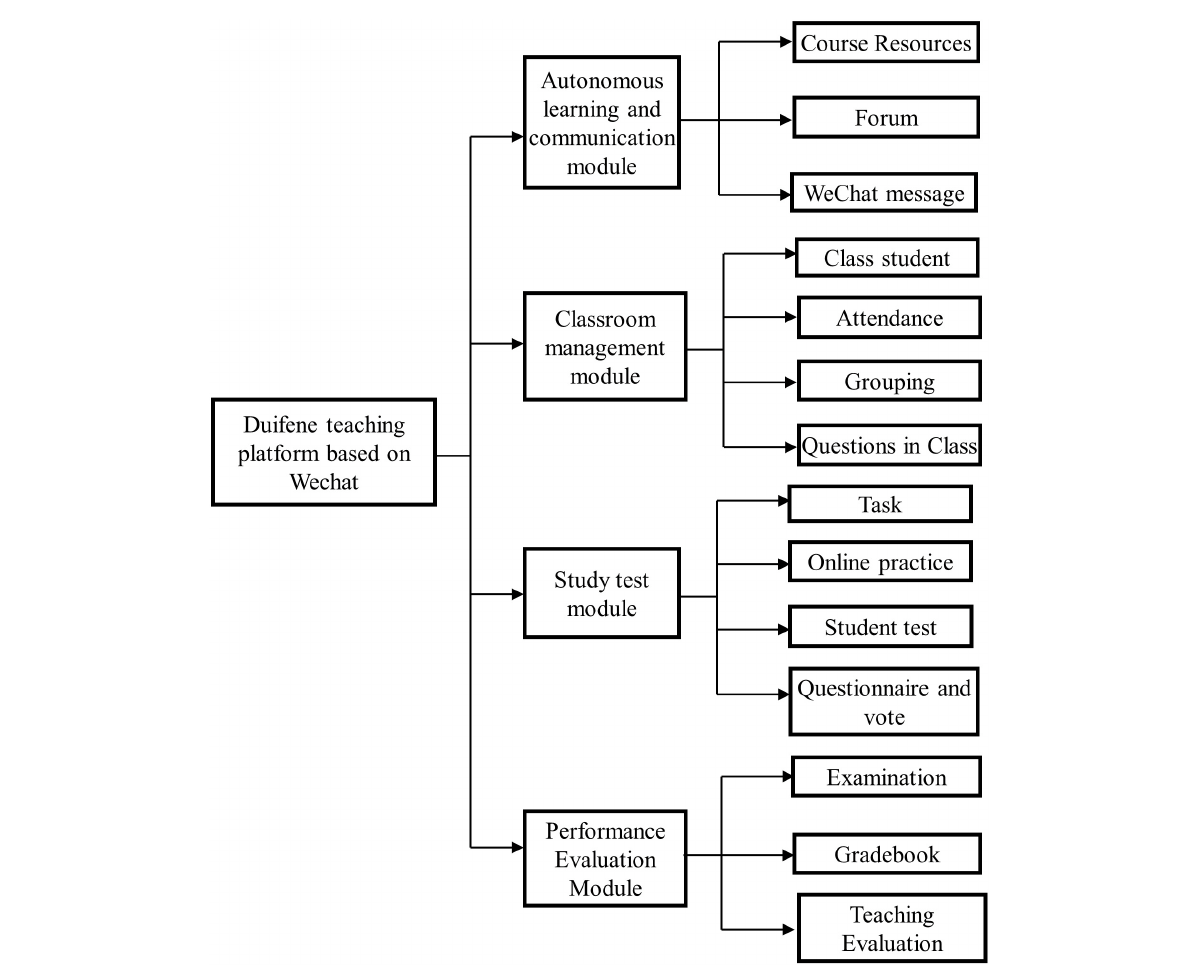
FIGURE3 The function structure provided by the Duifene teaching platform.